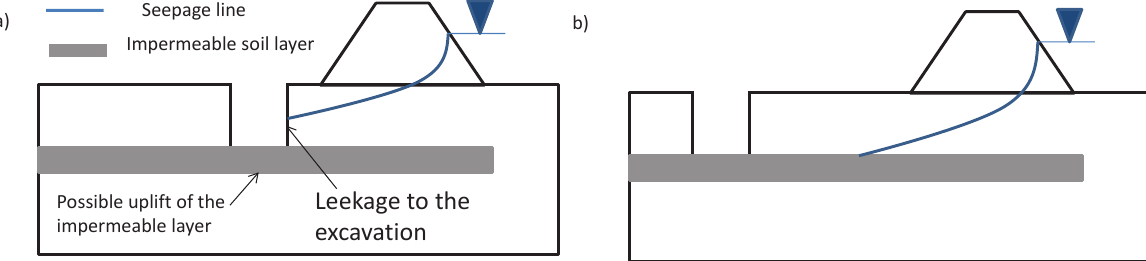
Figure 2: Interaction between embankment and excavation during the flood: (a) excavation “close” to the embankment – leakage to the excavation and uplift of the impermeable layer possible and (b) excavation “far” from the embankment – no interaction.